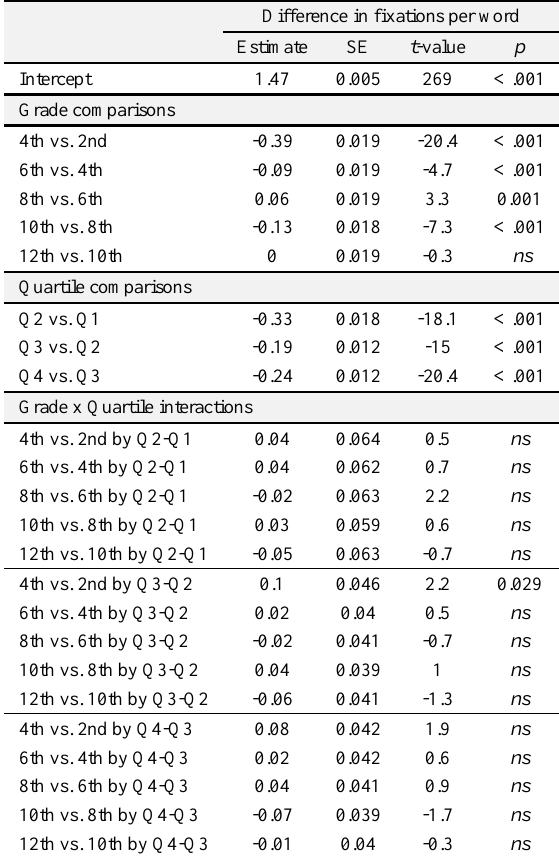
Table 4. Differences in Fixations Per Word Between Grades and Reading Rate Quartiles Difference in fixations per word